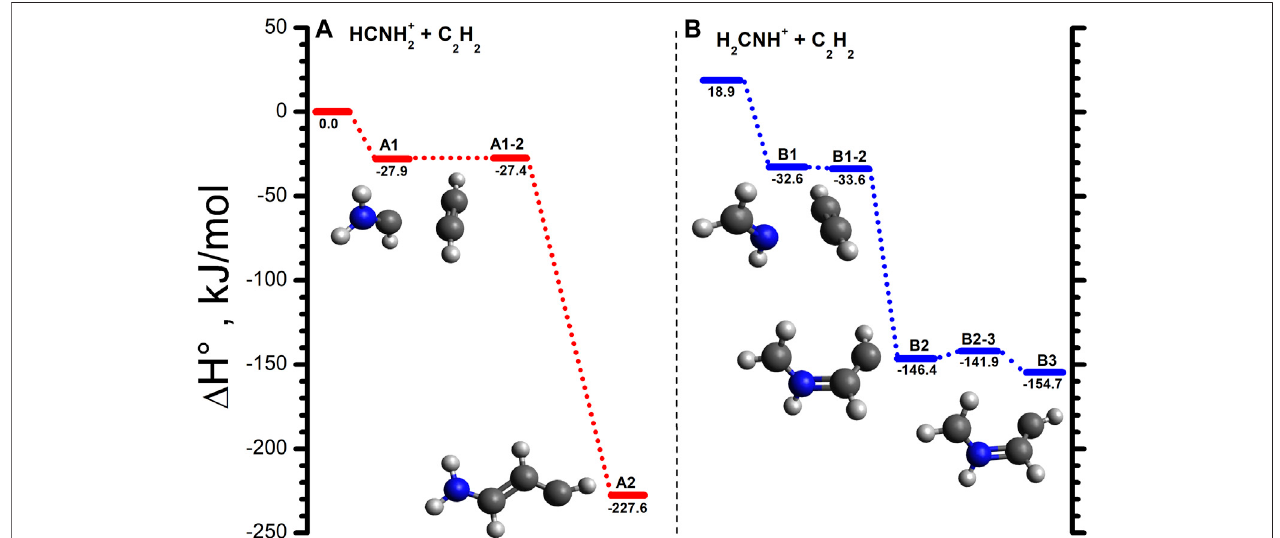
FIGURE6| StructuresandenergiesofthevanderWaalsadducts(andtheirevolutionintocovalentlyboundintermediates)fortheentrancechannelofthereactions of HCNH 2+ (cid:129) (panel A) and H 2 CNH + (cid:129) (panel B) plus C 2 H 2 . Energies (in kJ/mol) are de fi ned with respect to the separated HCNH 2+ (cid:129) plus C 2 H 2 reactants. Calculations are at the MP2/6-311++G(d,p)//CCSD(T)/6-311++G(d,p) level of theory.